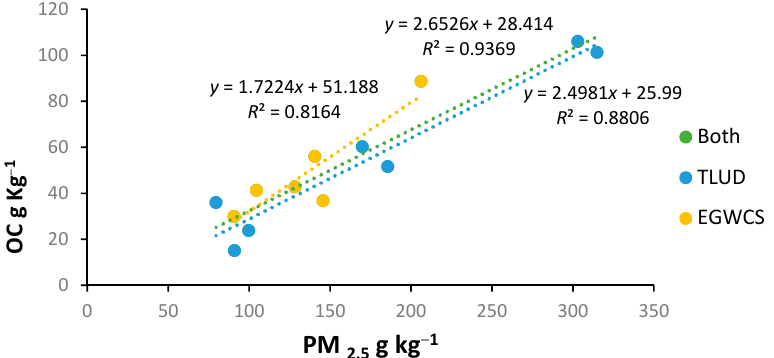
Figure 1. Relationships between total suspended particulate matter (PM 2.5 ) and organic carbon (OC) of each gasifier.